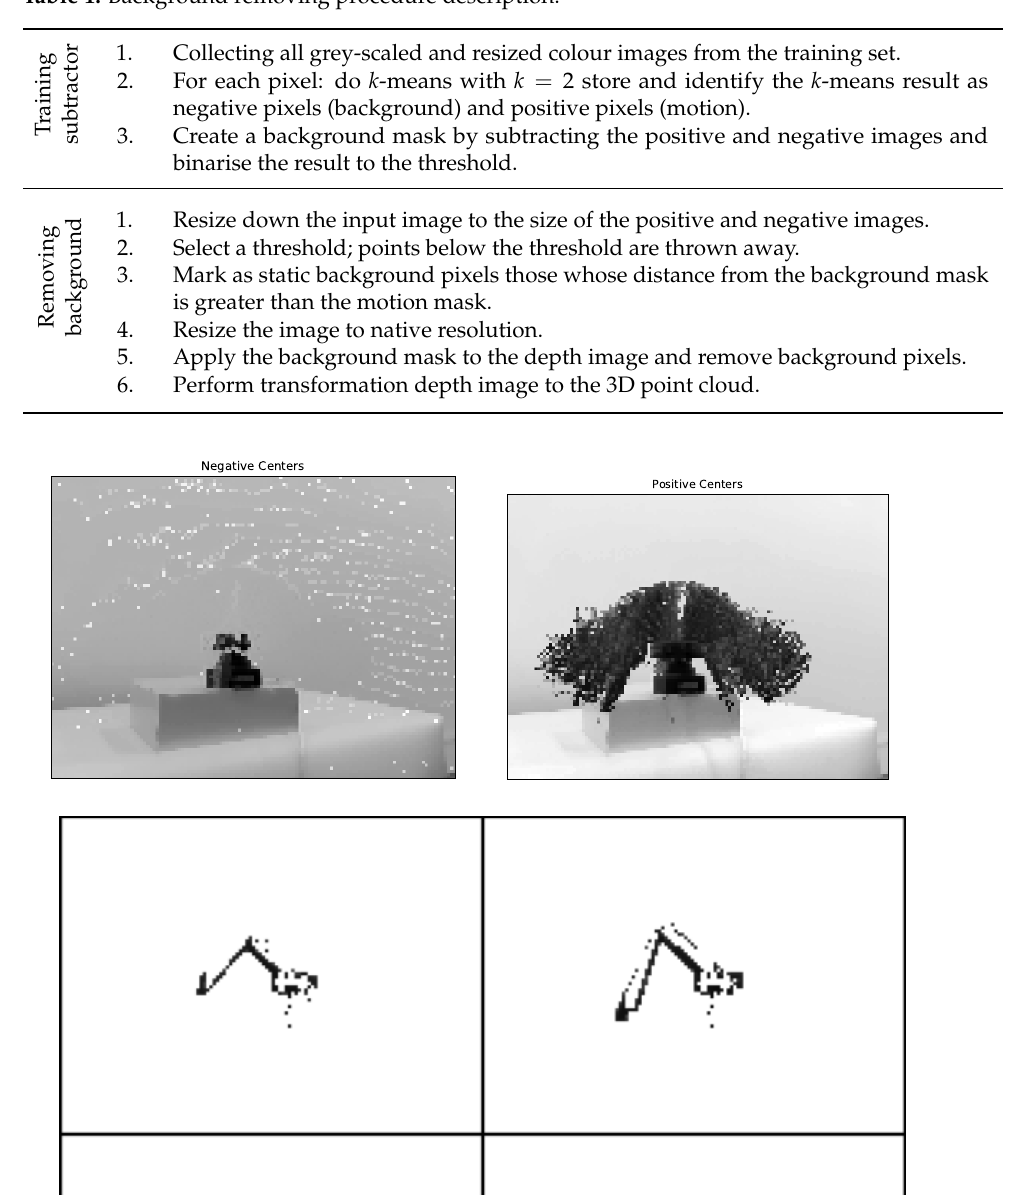
Table 1. Background removing procedure description.